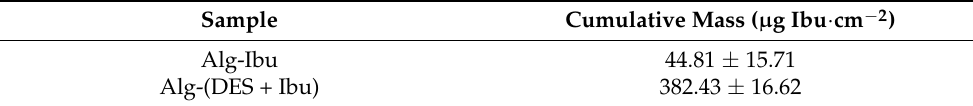
Table 1. The average cumulative mass of ibuprofen after 6 h permeation from the hydrogel with ibuprofen and the hydrogel with ibuprofen solubilized in the DES aqueous solution test across hu- man epidermis.